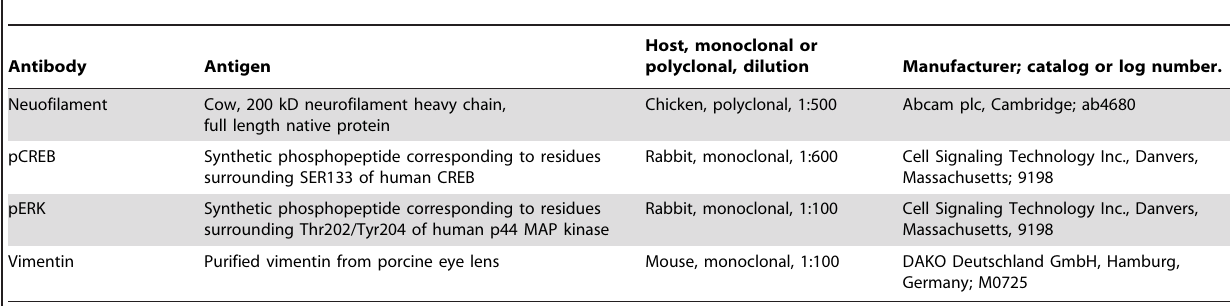
Table 1. Primary antibodies and their dilutions used for immunofluorescence analysis.